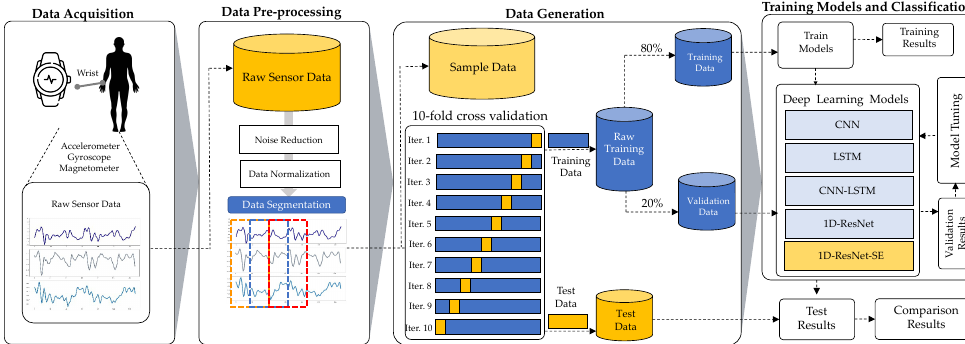
Figure 1. The proposed CHM-UserIden framework for smartwatch-based user identification used in this